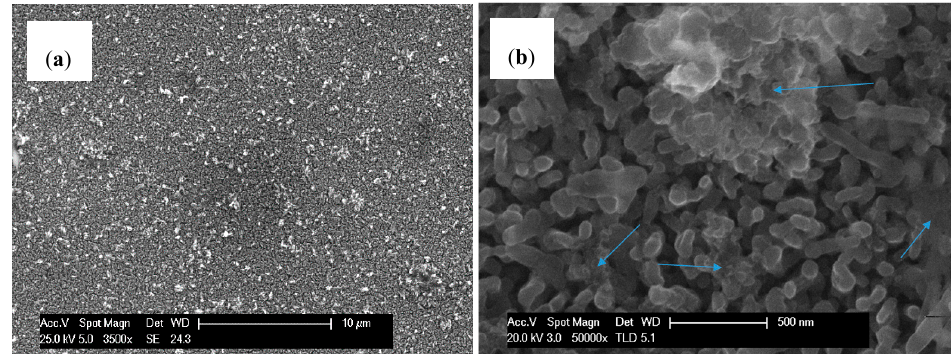
Figure 6. SEM image of the most performing photoanode after the polarization tests at ( a ) a low and ( b ) a high magnification; arrows indicate co-catalyst clusters corresponding to the bright particles in the low-magnification